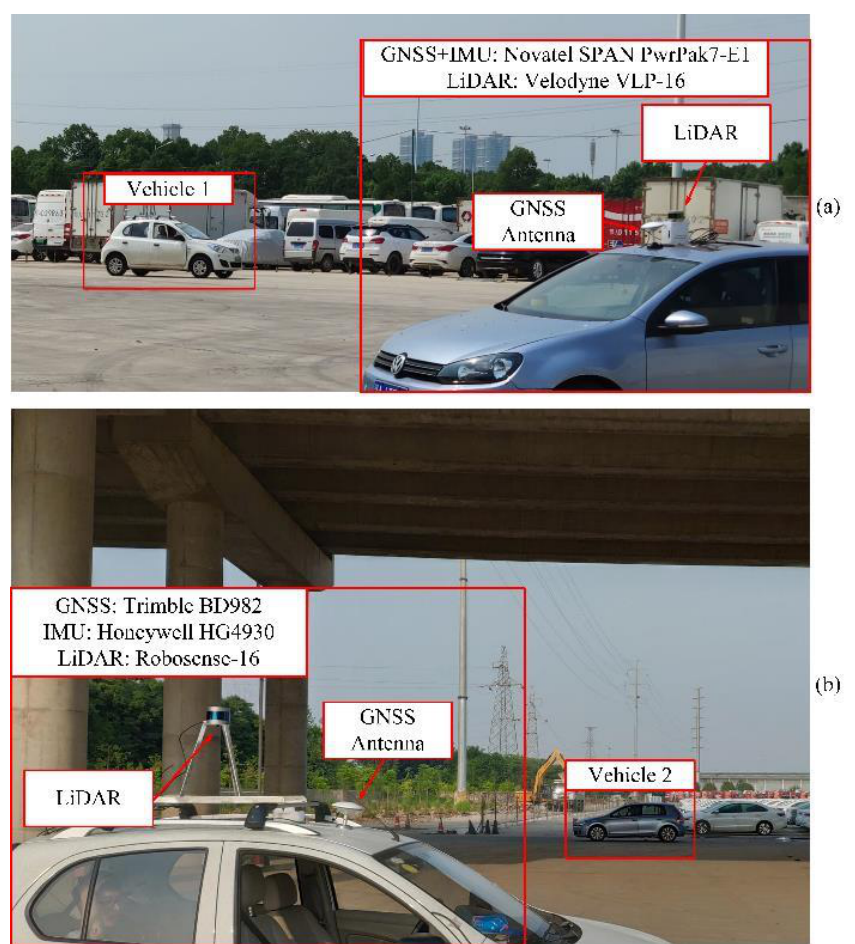
Figure 4. Vehicles used in our experiments with red frames, and locations and types of their GNSS, inertial measurement unit (IMU) and Light Detection And Ranging (LiDAR) equipment. ( a ) open area; ( b ) below a Table 2. Characteristics of the gyroscopes and accelerometers from the Novatel Span Pwrpak7-e1 and the Honeywell HG4930.